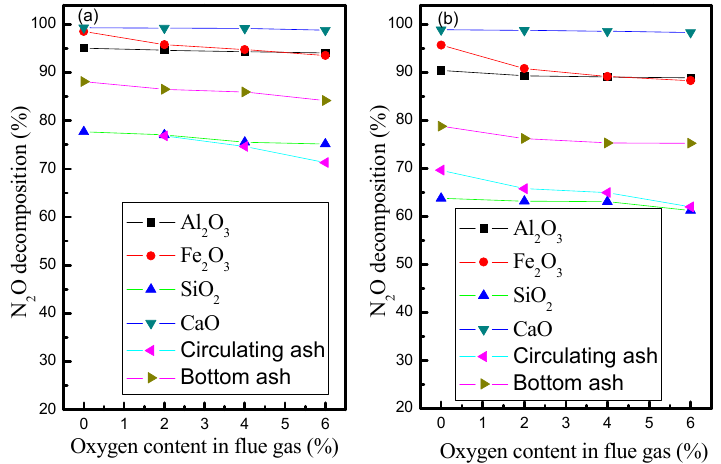
O decomposition without biomass gas: Figure 8. Influence of bed material on N 2 ( a ) N O = 2000 ppm; ( b ) N O = 2800 ppm (with a height of bed material of 40 2 2